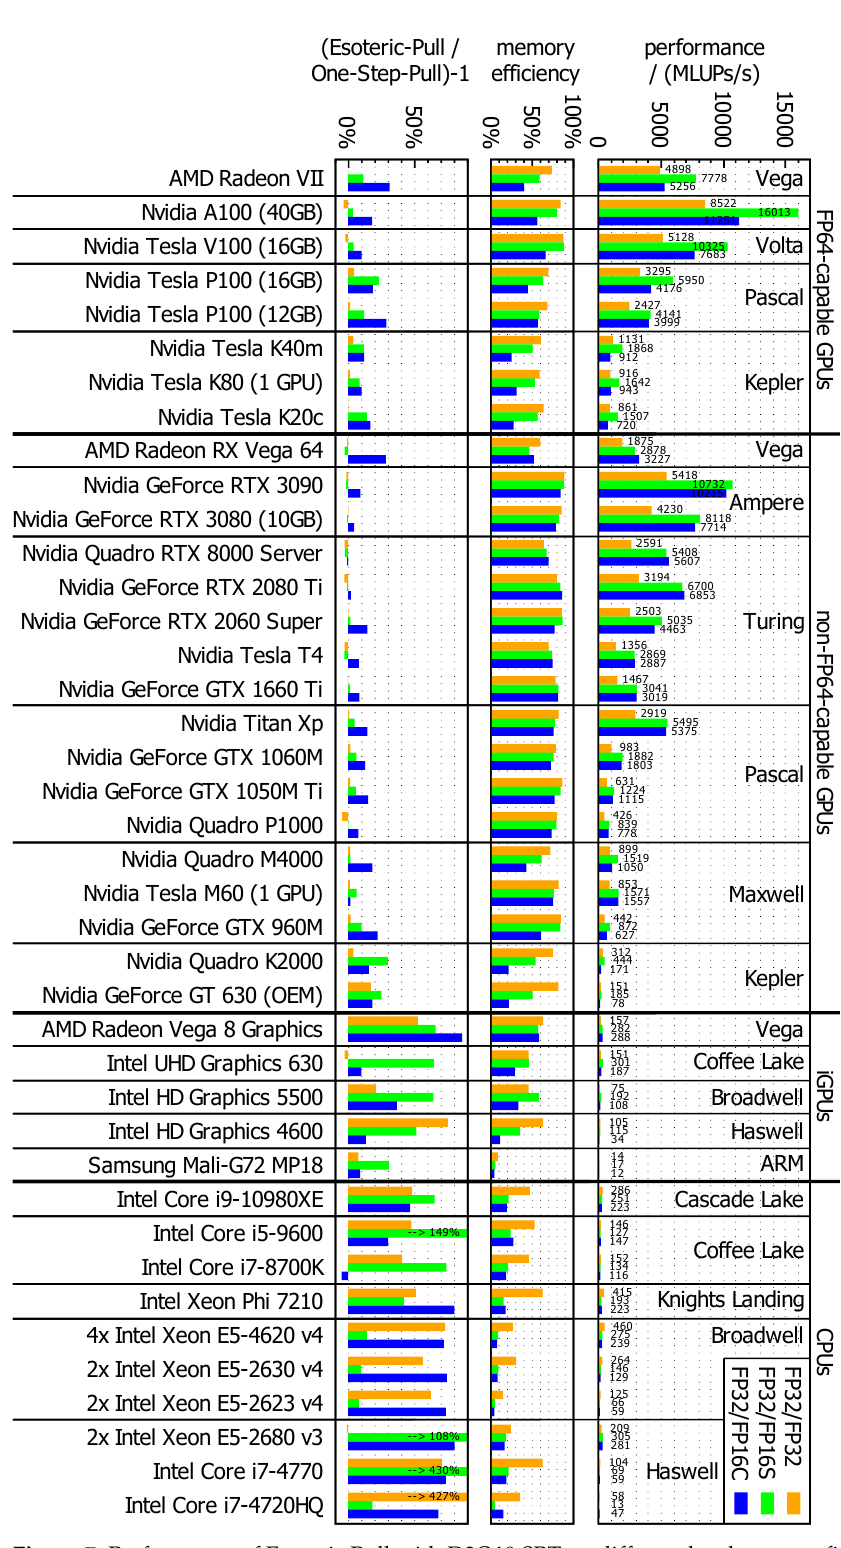
Figure 7. Performance of Esoteric Pull with D3Q19 SRT on different hardware configurations in the FluidX3D OpenCL implementation, in million lattice updates per second (MLUPs/s). Efficiency is calculated by dividing the measured MLUPs/s by the data sheet memory bandwidth times the number of bytes transferred per lattice point and time step (Table 1). CPU benchmarks are on all cores. Performance comparison with the One-Step-Pull streaming scheme [13] shows only insignificant differences on most dedicated GPUs, but large gains on integrated GPUs and